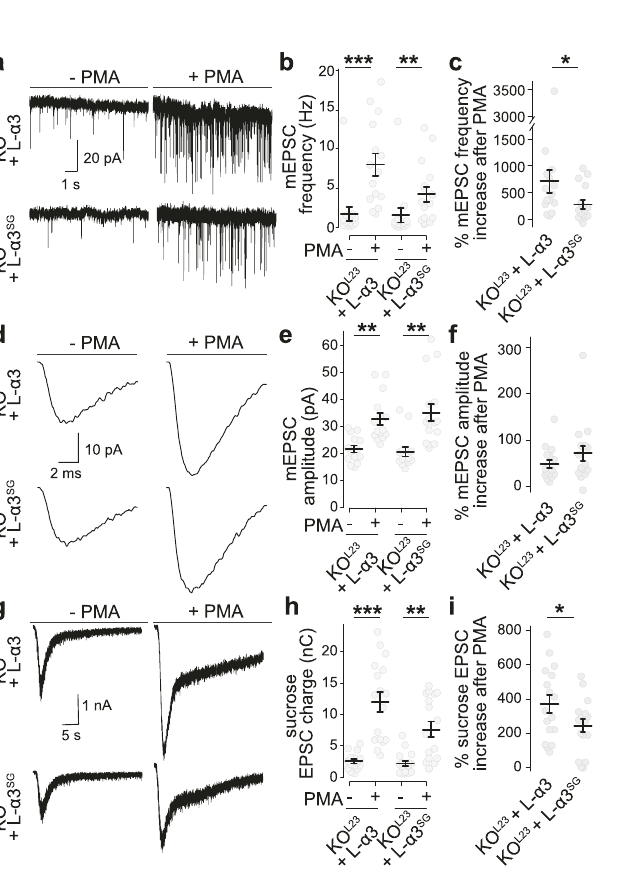
Fig. 6 Liprin- α 2/ α 3 double knockout impairs neurotransmitter release. a-c Example traces ( a ) of spontaneous miniature excitatory postsynaptic current (mEPSC) recordings (top) and an averaged mEPSC of a single cell each (bottom), and quanti fi cation of mEPSC frequency ( b ) and amplitude ( c ), control L23 : N = 15 cells/3 independent cultures, KO L23 : N = 21/3, p values: b , 0.003 (**); c, 0.55. d , e Example traces ( d ) and average amplitudes ( e ) of single action potential-evoked NMDA receptor-mediated EPSCs, control L23 : N = 25/3, KO L23 : N = 26/3, p value: 0.63. f , g Example traces ( f ) and average NMDA-EPSC paired pulse ratios ( g ) at various interstimulus intervals, control L23 : N = 25/3, KO L23 : N = 23/3, p values: genotype 0.00002, interstimulus interval 0.009, interaction 0.007, post-tests: 20 ms 0.002 (**), 50 ms 0.11, 100 ms 0.16, 500 ms 0.18, 1 s 0.24. h , i Example traces ( h ) and quanti fi cation ( i ) of the AMPA receptor-mediated EPSC charge in response to a local 10 s puff of 500 mOsm sucrose to estimate the RRP, control L23 : N = 21/3, KO L23 : N = 25/3, p value: 0.045 (*). j – r Same as a – i , but for IPSCs, j – l : control L23 : N = 18/3, KO L23 : N = 18/3; m + n : control L23 : N = 23/3, KO L23 : N = 24/3; o + p : control L23 : N = 23/3, KO L23 : N = 23/3, q + r : control L23 : N = 22/3, KO L23 : N = 22/3, p values. k , 0.046 (*); l , 0.12; n , 0.002 (**); p , genotype 0.37, interstimulus interval 2e-8, interaction 0.96; r , 0.011 (*). s Diagram of the rescue experiment with Liprin- α 3 expression via lentiviral transduction. t , u Example traces ( t ) and quanti fi cation ( u ) of sucrose-triggered EPSCs, KO L23 : N = 22/3, KO L23 + Liprin- α 3 (L- α 3): N = 23/3, KO L23 + Liprin- α 3 S760G (L- α 3 SG ): N = 23/3, p values (compared to KO L23 ): KO L23 + L- α 3, 0.006 (*); KO L23 + L- α 3 SG , 0.53. v , w Representative STED images ( v ) and quanti fi cation ( w ) of RIM at the active zone of side-view synapses as in Fig. 3i – j. KO L23 : N = 56 synapses/3 independent cultures, KO L23 + L- α 3: N = 43/3, KO L23 + L- α 3 SG : N = 50/3. p values: KO L23 + L- α 3, 0.003 (**); KO L23 + L- α 3 SG , 0.18. All data were mean ± SEM. Signi fi cance was assessed using Mann – Whitney U- tests ( b , c , i , k , l ), t -tests ( e , n , r ), two-way ANOVA ( g , p ), or Kruskal – Wallis ( u , w ) with Tukey – Kramer ( g , p ) or Holm ( u , w ) post hoc comparison against KO L23 (comparison between all groups were performed, but only results against KO L23 are reported in u and w ). All tests were two-sided. For a direct comparison of control L23 , KO L23 and KO L23 + L- α 3 and for STED localization of rescue Liprin- α , see Supplementary Fig. 9.